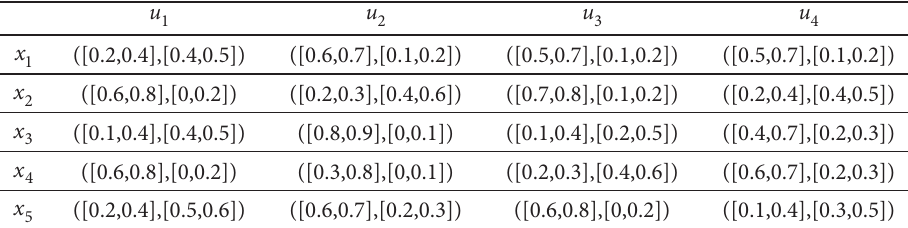
Table 4. Interval-valued intuitionistic fuzzy decision matrix